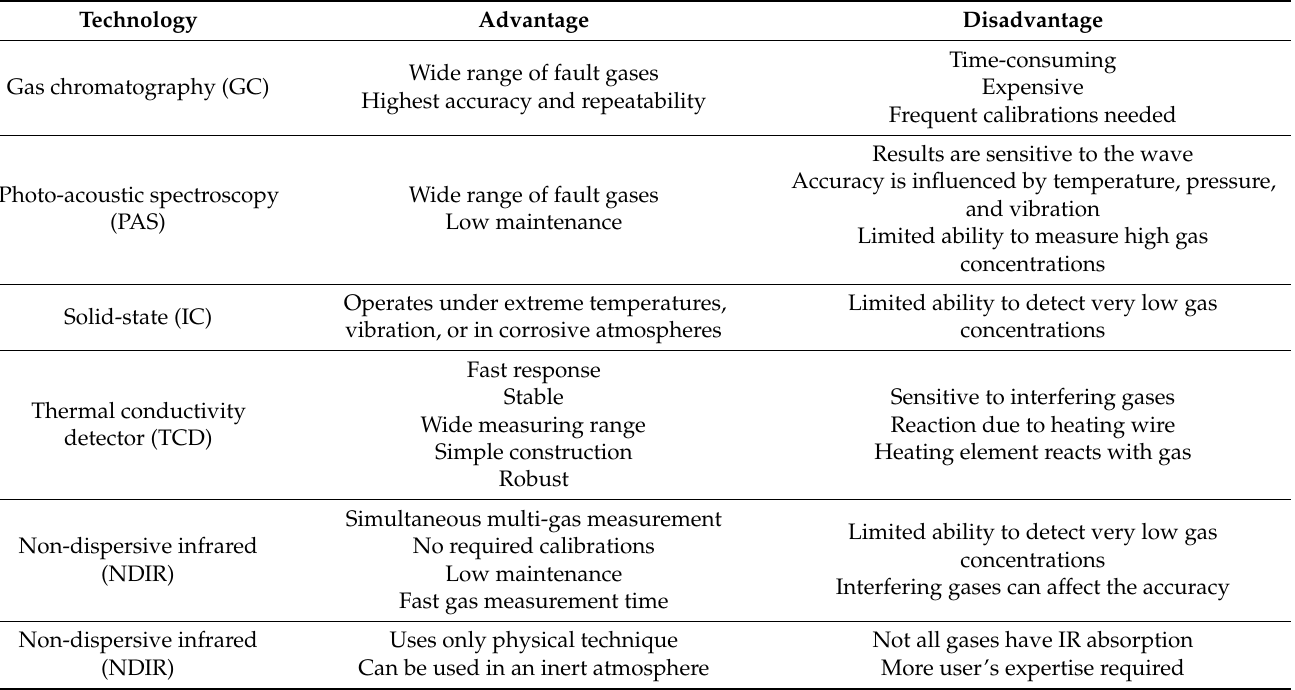
Table 6. Advantages and disadvantages of gas detection technologies